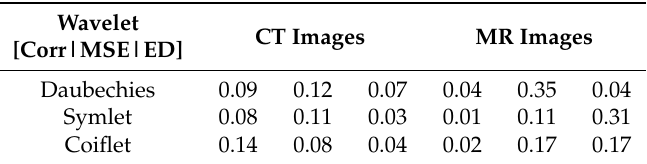
Table 2. Distribution of p-values of Chi-squared test normality for the Gaussian noise with dynamical noise intensity: µ = 0, σ = 0.01 −